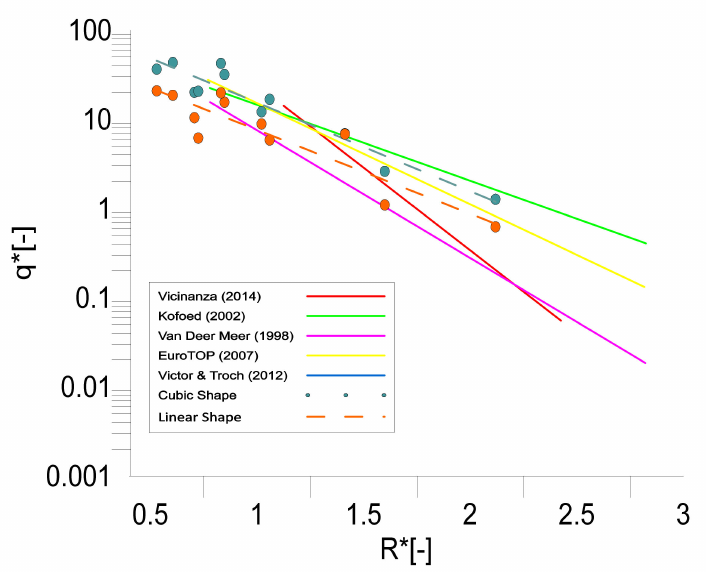
Figure 19. Comparison of non-dimensional overtopping discharge between cubic and linear shape to the previous